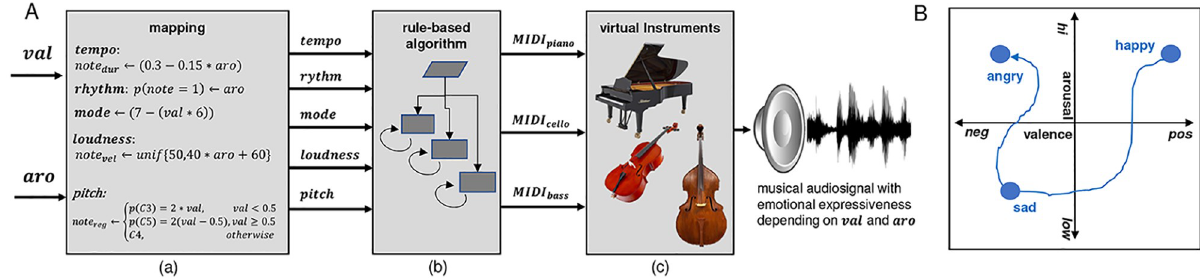
Fig 2. Schematic illustration of the automatic music generation system. (A) mapping of valence and arousal onto music structural parameters (a), state-machine to generate MIDI patterns (b), virtual instruments to translate MIDI patterns into sound (c). (B) Exemplary synthesized musical trajectory through affective space (valence-arousal-model according to